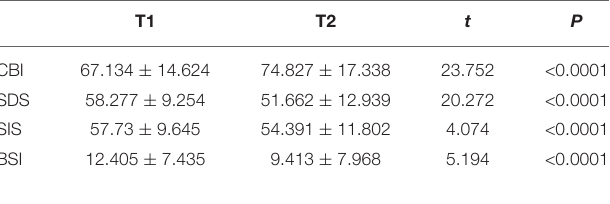
TABLE 1 | Comparison of psychological indexes of patients before (T1) and 3 months after (T2) social work service.